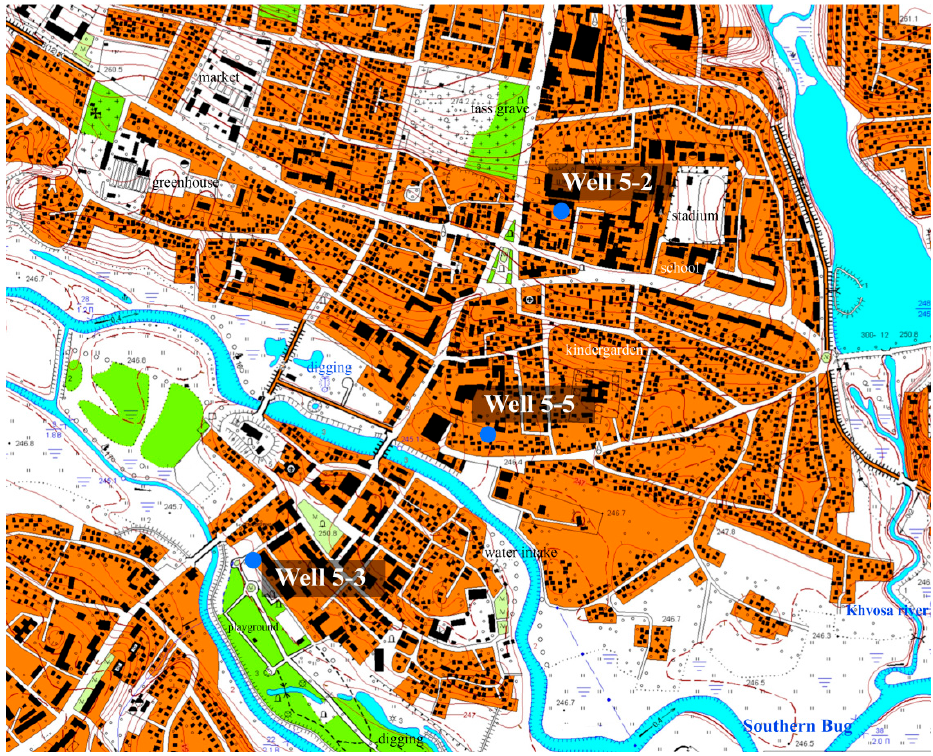
Figure 3. Location of wells #5-2, #5-3 and #5-5 within the city of Khmilnyk.